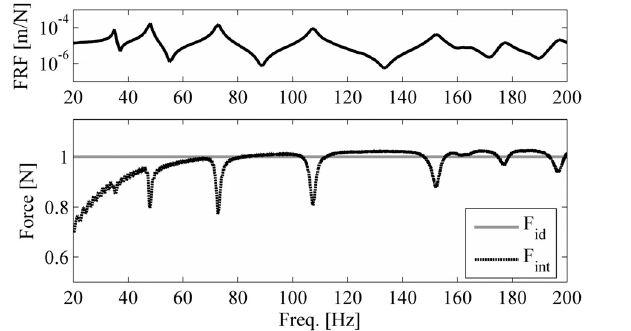
Fig. 9. System driving point FRF and input forces.